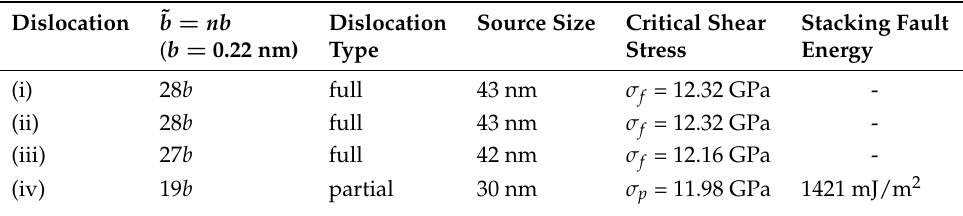
Figure 3. Edge dislocation result and simulation. ( a ) Reconstructed stress field in the vicinity of an edge dislocation within the nanoparticle shell region (magnified 3X) is compared with simulated stress ( b ) Stress due to an edge dislocation. ( c ) The overall region of the reconstructed core–shell structure. Table 1. The calculated values for each